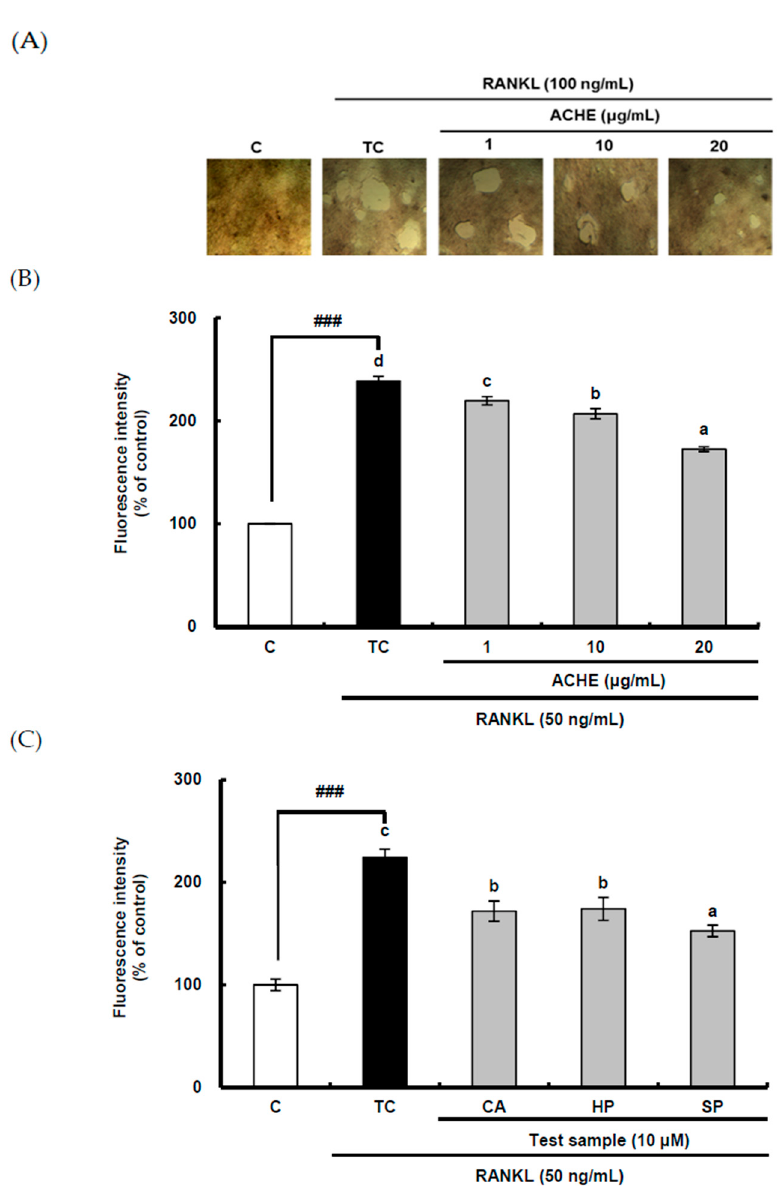
Figure 4. Inhibitory effect of hydroethanolic extract of A. capillaris and its bioactive compounds on bone resorption. ( A ) The visualized absorbed area with ACHE treatment; ( B ) The fluorescence intensity of the absorbed area with treatment with ACHE and ( C ) three bioactive compounds. A bone resorption assay was performed using a commercial assay kit. RAW 264.7 cells were exposed to RANKL (100 ng/mL) for 5 days in the absence and presence of ACHE or three compounds. The absorbed areas on each plate were visualized at 200-fold magnification under light microscopy. Fluorescence intensity was measured at an excitation wavelength of 485 nm and an emission wavelength of 535 nm using a fluorometric plate reader. Data are expressed as percentages of the values of untreated cells (means ± standard deviations, n = 3). Different corresponding letters indicate significant differences at p < 0.05 by Duncan’s test. ### p < 0.001 vs. C. C: control, which was not treated; TC: treated control, which was treated with RANKL; CA: chlorogenic acid; HP: hyperoside; SP: scoparone.